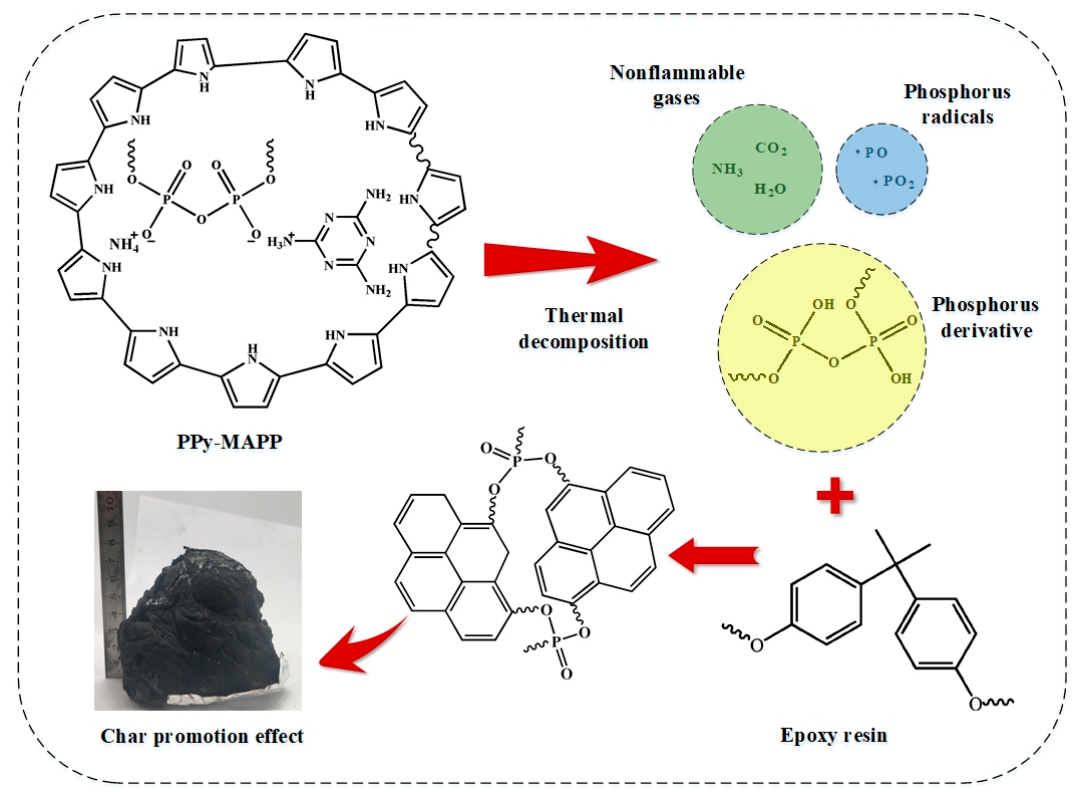
Figure 12. Flame-retardant mechanism of EP/PPy-MAPP composites.